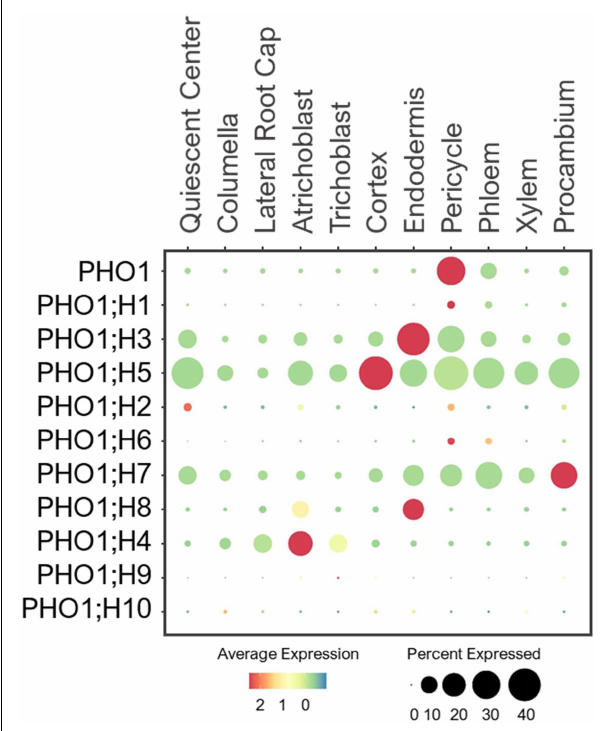
FIGURE 8 | Expression of the PHO1 transporters in Arabidopsis root single cells. In dot plot, the circle size represents the proportion (%) of cells expressing a given gene, and the color of scale bar represents the mean expression (natural log +1